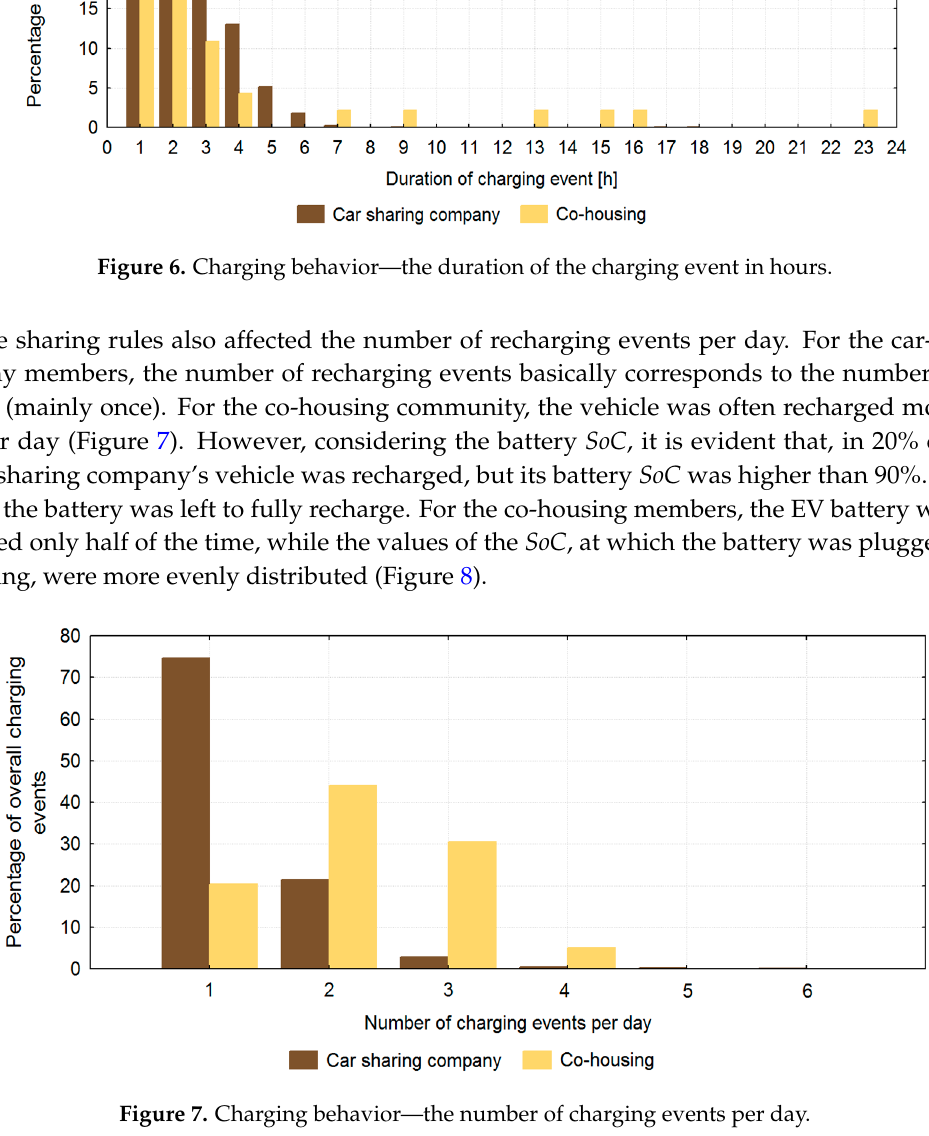
Figure 5. Charging behavior—the duration of charging event in days.